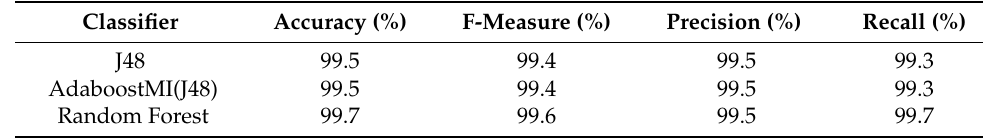
Table 6. Performance metrics of machine learning